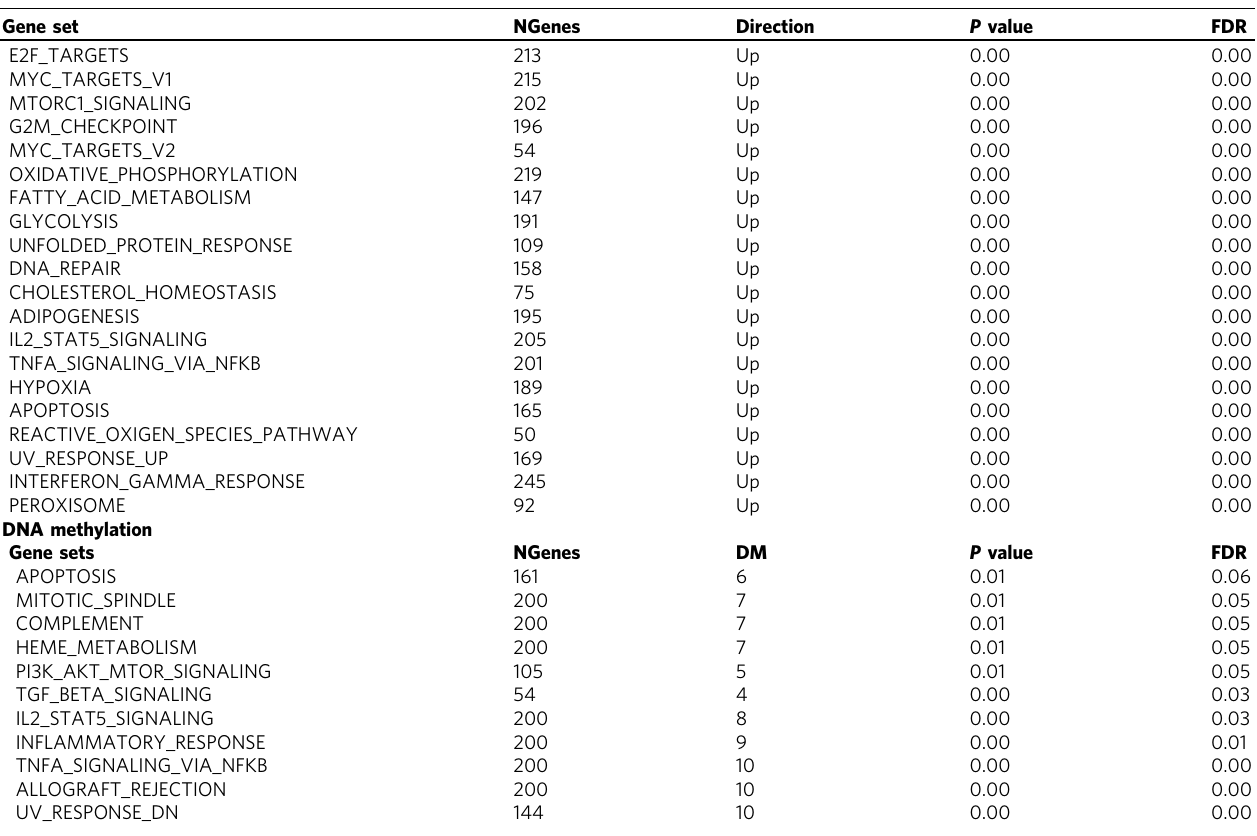
Table 1 Gene sets analysis of differentially expressed and methylated genes in activated vs. quiescent T cells RNA-seq Gene